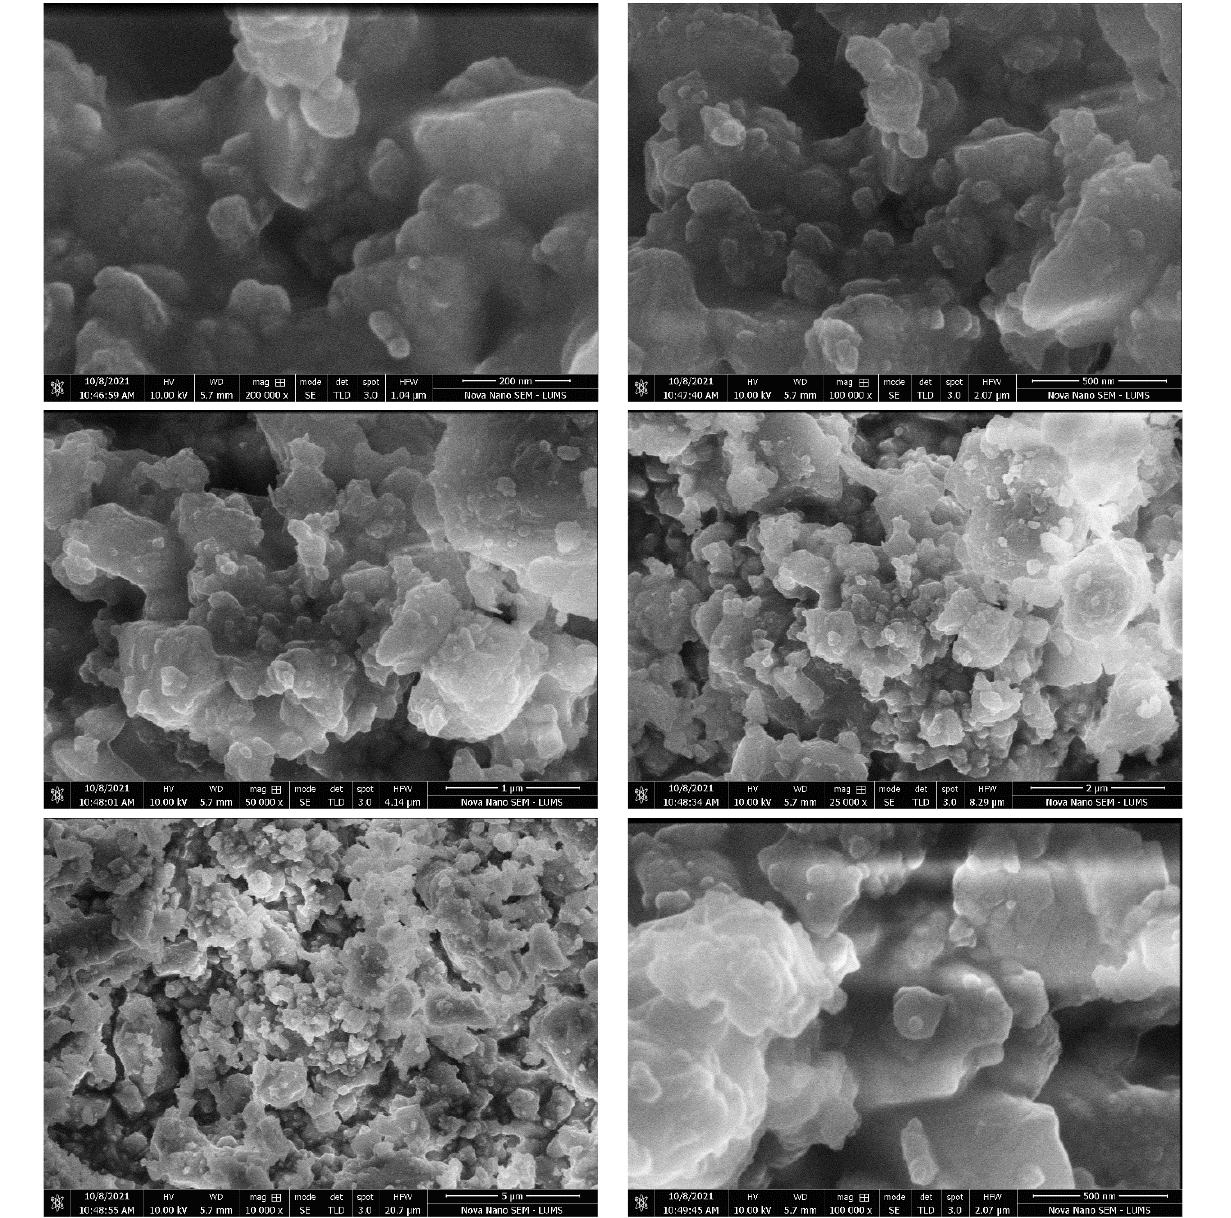
Figure 6. SEM analysis of hoshanar marble waste.